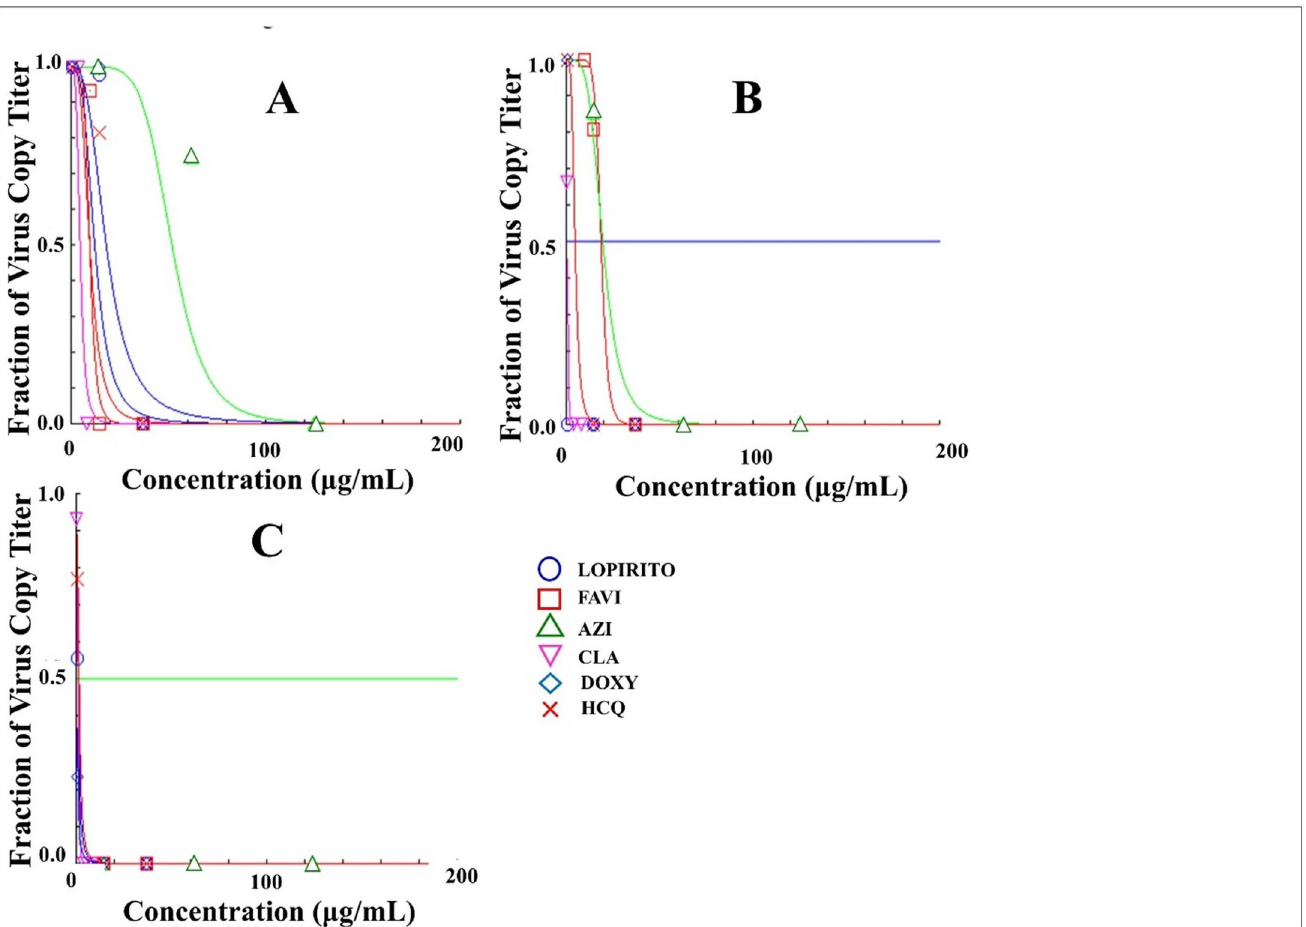
Fig 13. The efficacy (IC 50 ) evaluation of Lopinavir-Ritonavir (LOPIRITO), Favipiravir (FAVI), Azithromycin (AZI), Clarithromycin (CLA), Doxycycline (DOXY), and Hydroxychloroquine (HCQ) as a single drug in Vero cells infected with SARS-CoV-2 virus isolates for 24 hours (A), 48 hours (B), and 72 hours (C) analysed using CompuSyn Software at a multiplicity of infection (MoI) value of